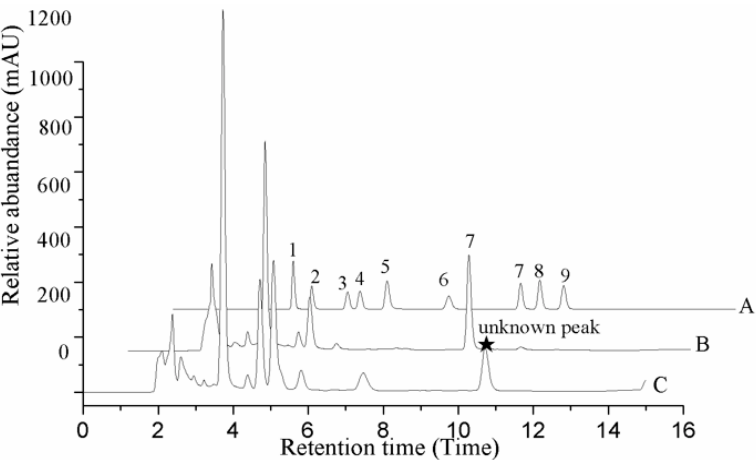
Figure 3. HPLC profile of O. sinensis . A. Standard samples. B. Natural fruit body. C. Cadaver of Hepialidae . 1. Uracil; 2. Uridine; 3. Inosine; 4. Guanosine; 5. Adenine; 6. Thymidine; 7. Adenosine; 8. 2-deoxyadenosine; 9. Cordycepin.